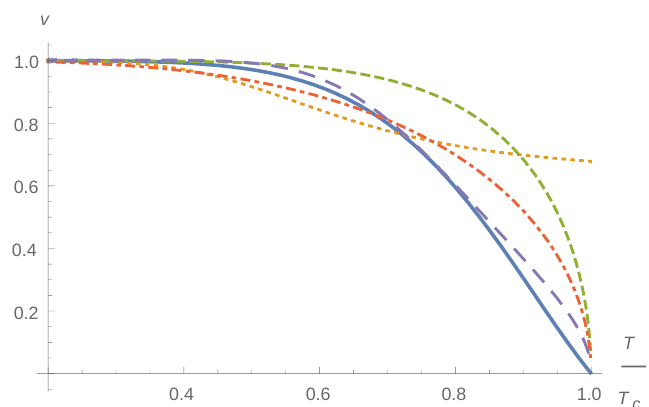
( WSS ) = 0 . 16 . The dotted line is the d = 1 , f = 10 , where f χ /M KK